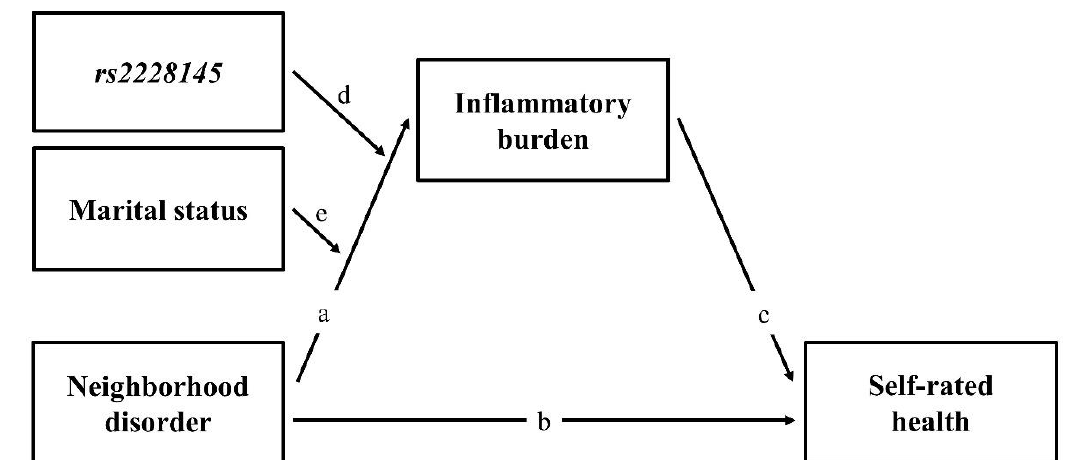
Figure 1. Theoretical model showing hypothesized pathways.